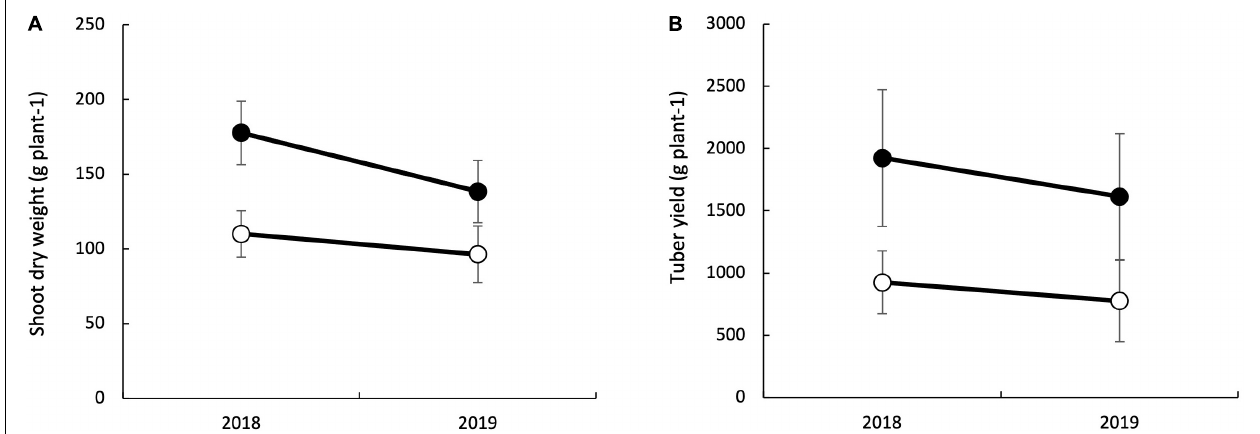
FIGURE 2 | Effects of fertilizer application on shoot dry weight at 150 days after planting (A) and tuber yield (B) of white Guinea Yam varieties. Bars indicate the standard deviation ( n = 21).